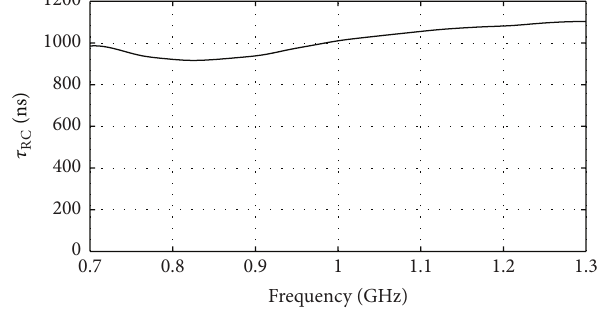
Figure 6: Measured chamber decay time 𝜏 RC .